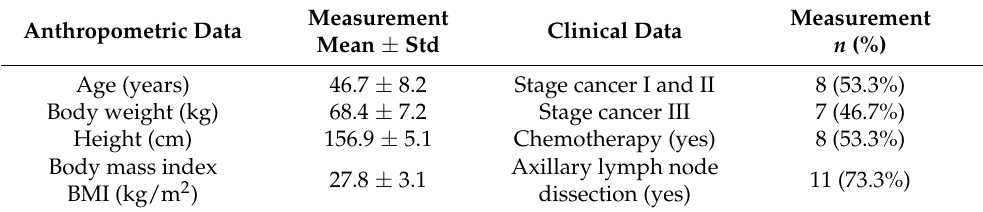
Table 1. Anthropometric characteristics of the participants and data related to breast cancer.